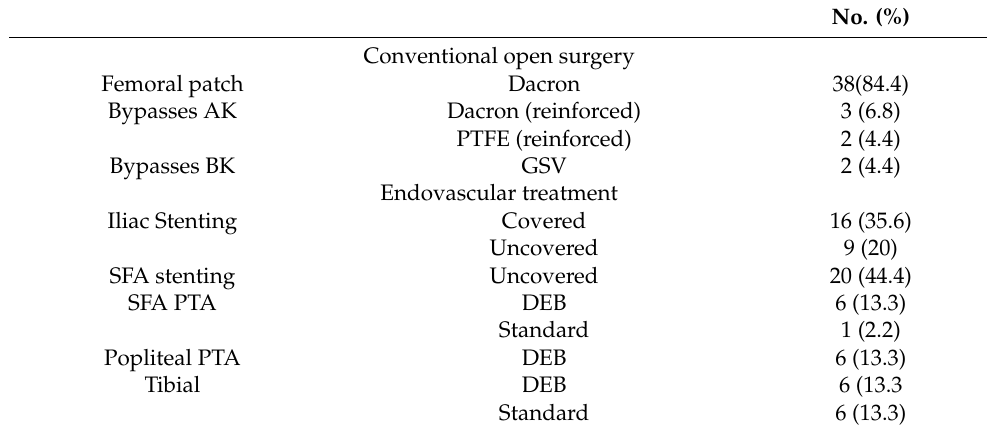
Table 2. Hybrid treatment operative